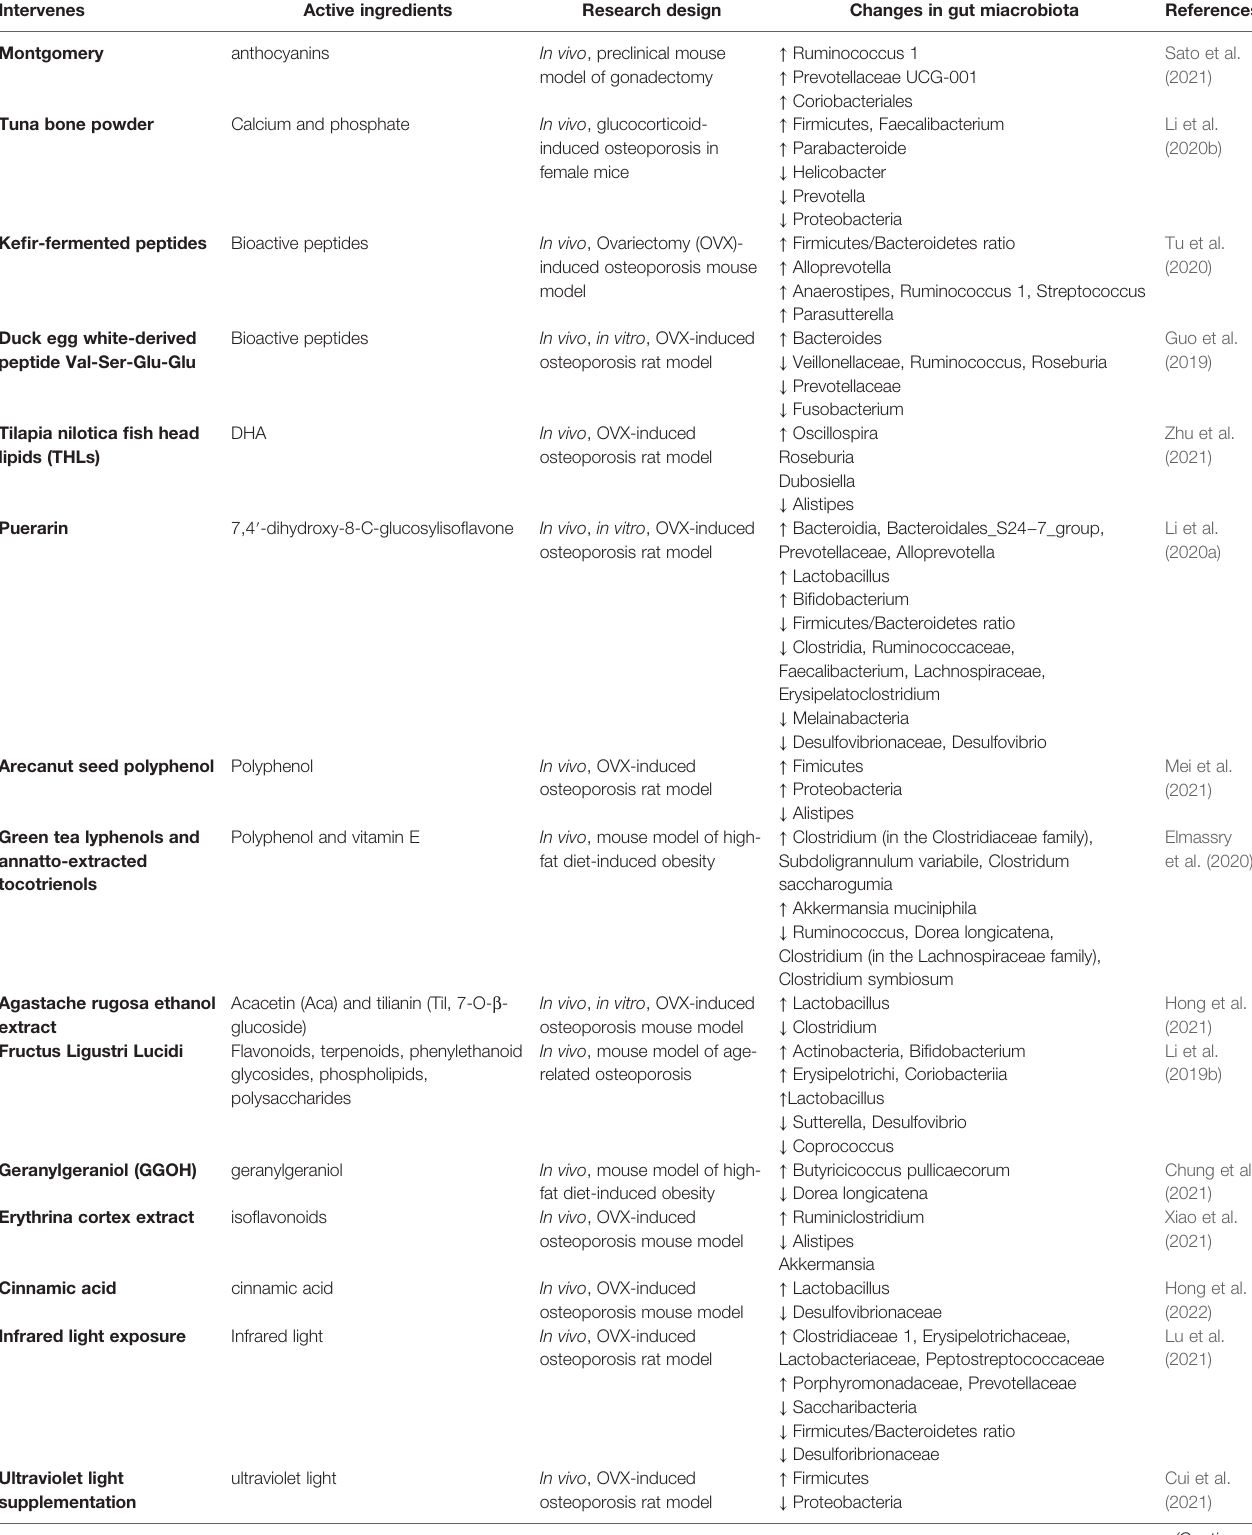
TABLE 1 | Ingredients that contribute to bone health reported in previous